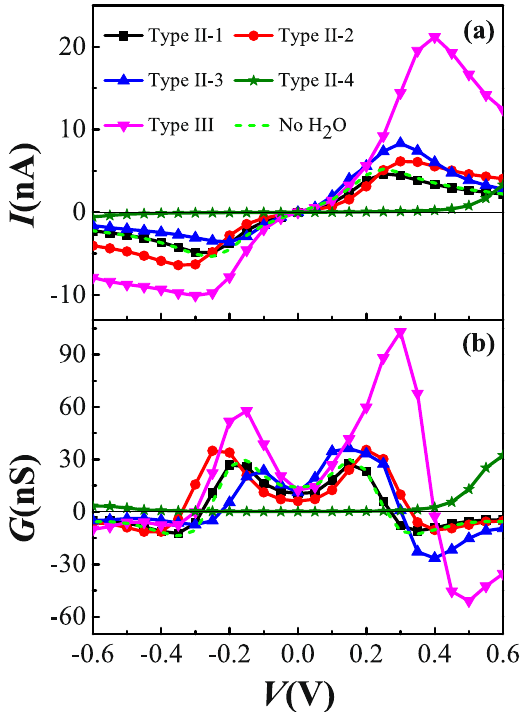
Figure 5. Electronic transport properties of TADHA molecular junction with two or three H 2 O molecule adsorbates. ( a ) Current and ( b ) Differential conductance as functions of applied bias